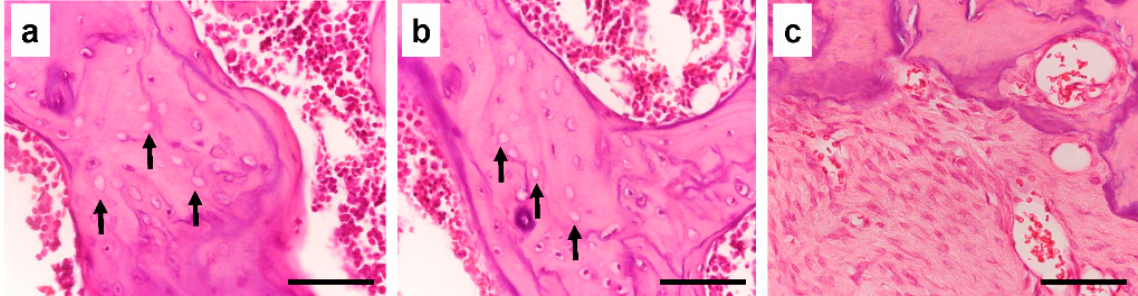
Figure 2. Histological analysis of distal femur. Cancellous bone shows focal osteonecrosis represented by empty lacunae (( a , b ): arrows) and fibrotic proliferation in the bone marrow ( c ). Black bars = 50 µm.